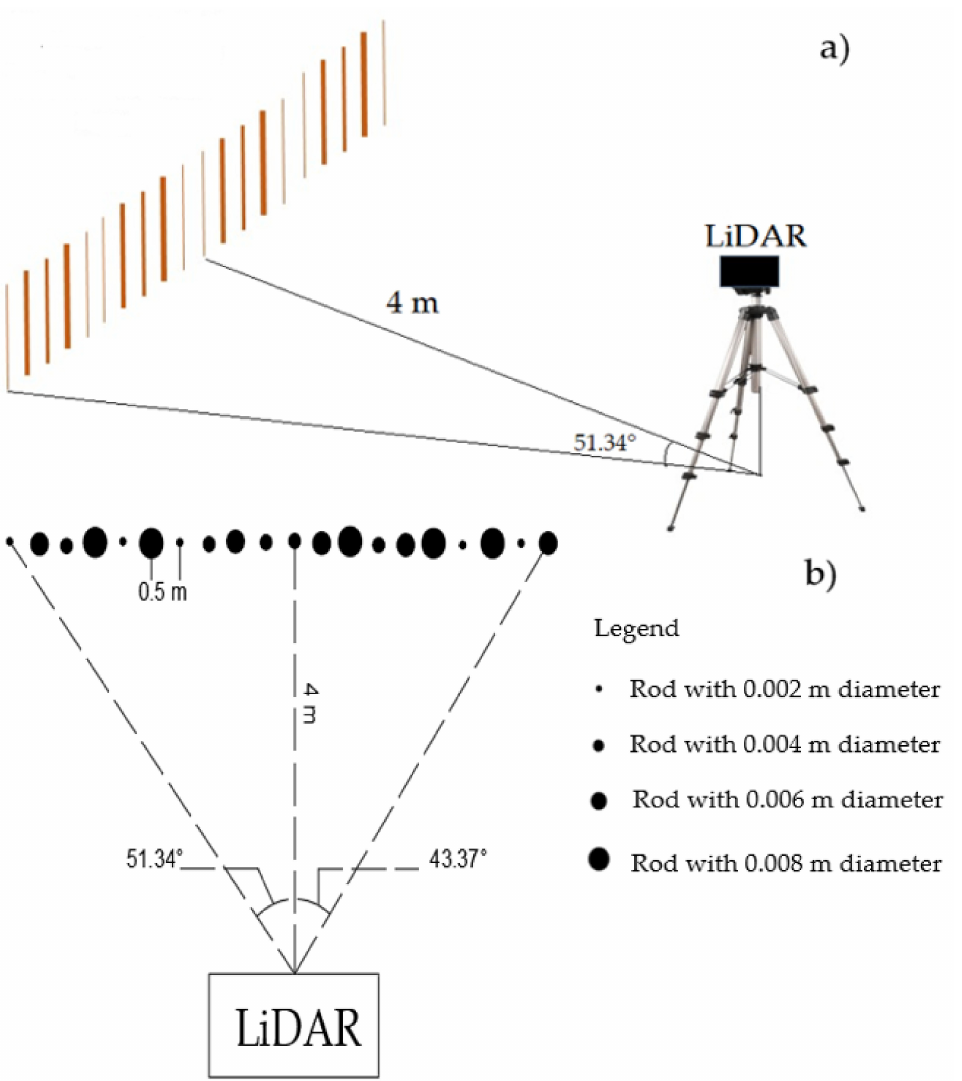
Figure 1. ( a ) Side-view and ( b ) bird’s-eye view of the single rods setup: 20 rods were spaced 0.5 m from each other, the LiDAR was at 4 m distance from the line of rods and pointing to the middle of the line. Black dots are symbols to show rods